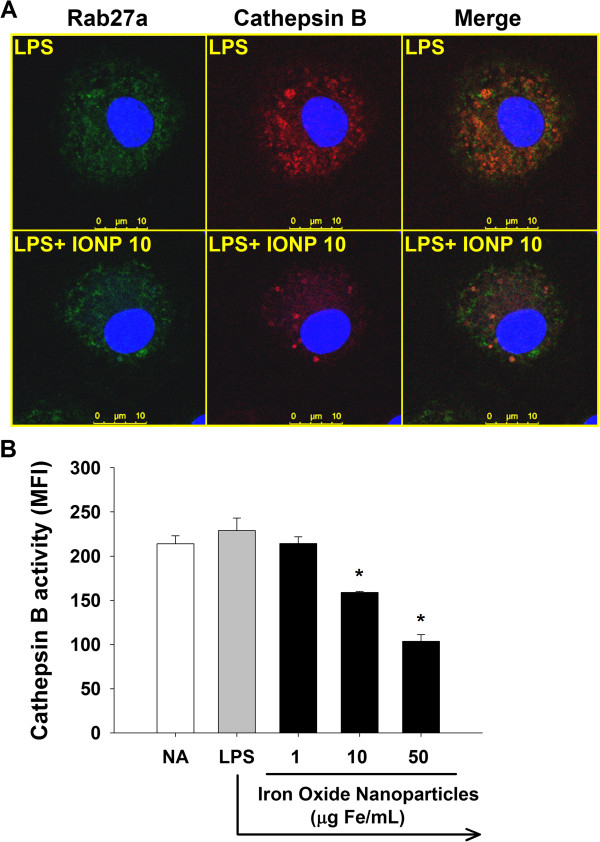
IONPs attenuated the cathepsin B enzyme activity of secretory lysosomes in LPS-stimulated microglia. Primary microglial cells (4 × 105 cells/mL) were either left untreated (naïve; NA), or pretreated with IONPs (1–50 μg Fe/mL) for 30 min followed by stimulation with LPS (100 ng/mL) for 24 h. (A) The cells pretreated with IONPs and stimulated with LPS were incubated with the cathepsin B substrate (red) for 1 h at 37°C and then stained for the secretory lysosome marker Rab27a (green). The fluorescence was visualized by confocal microscopy. Note the presence of orange signals in the merged images indicating the colocalization of cathepsin B and Rab27a. (B) The red fluorescence of 5000 single cells was measured by flow cytometry. Data are expressed as the mean ± SE of triplicate cultures. Results are a representative of three independent experiments. *p < 0.05 compared to the control group. MFI, mean fluorescence intensity.